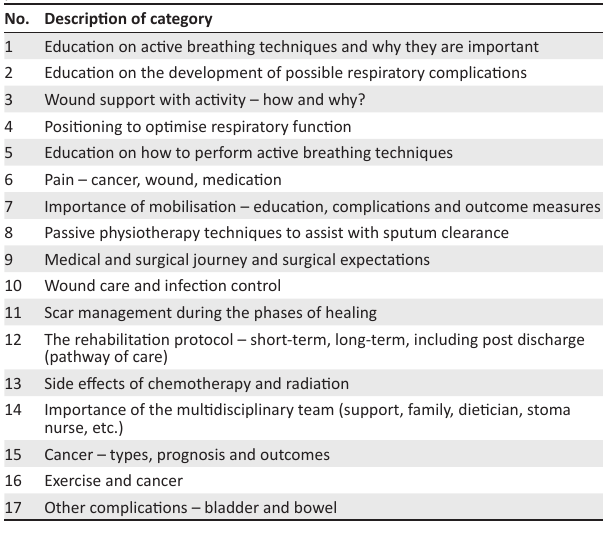
FIGURE 2: Ideas suggested by focus group participants related to the ‘respiratory system considerations’, ‘wound considerations’, ‘cancer-related considerations’ and ‘other considerations’ TABLE 4: Final ranking of categories for inclusion in preoperative education for patients with colorectal cancer.